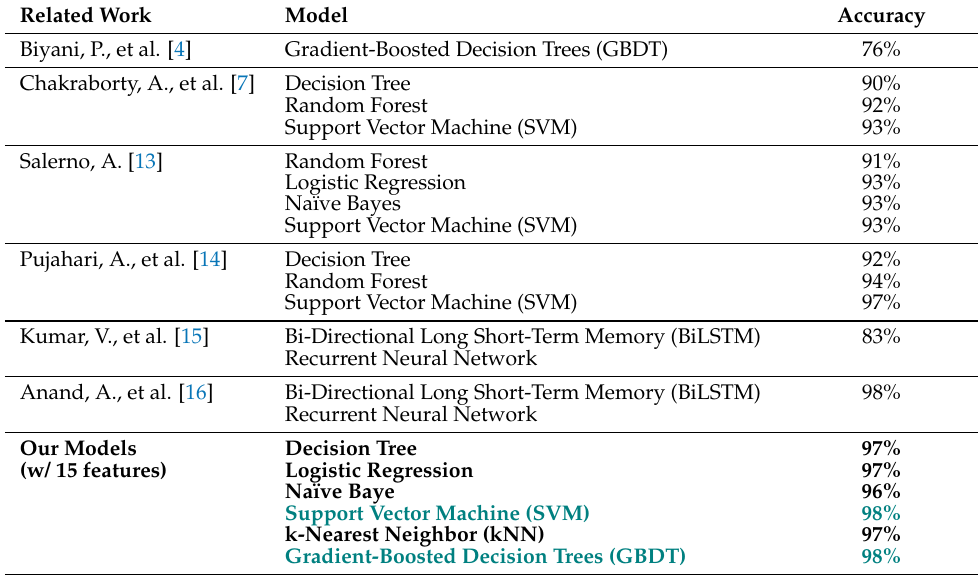
Table 8. Model Accuracy Comparisons to Related